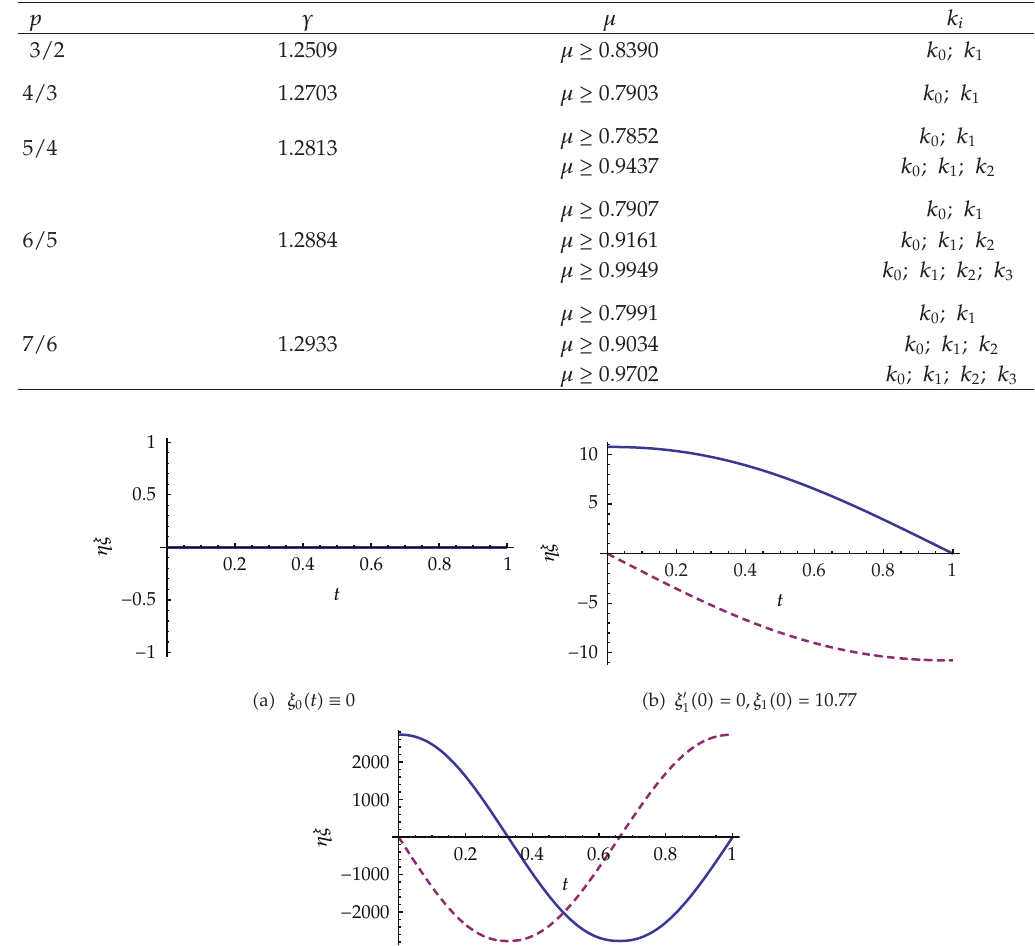
Table 1: Results of calculations for the problem (cid:3) 4.1 (cid:4) , (cid:3) 4.2 (cid:4) .